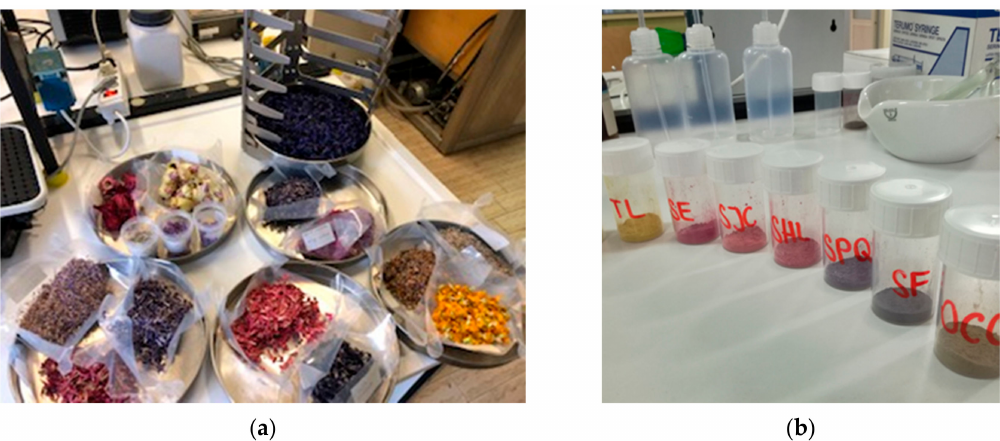
Figure 2. Two of the steps of sample preparation. ( a ) Samples after freeze-drying; ( b ) Samples after homogenization performed in 25 mL Teflon grinding jars with zirconium oxide grinding balls (MM2 Mixer Mill, Retsch,